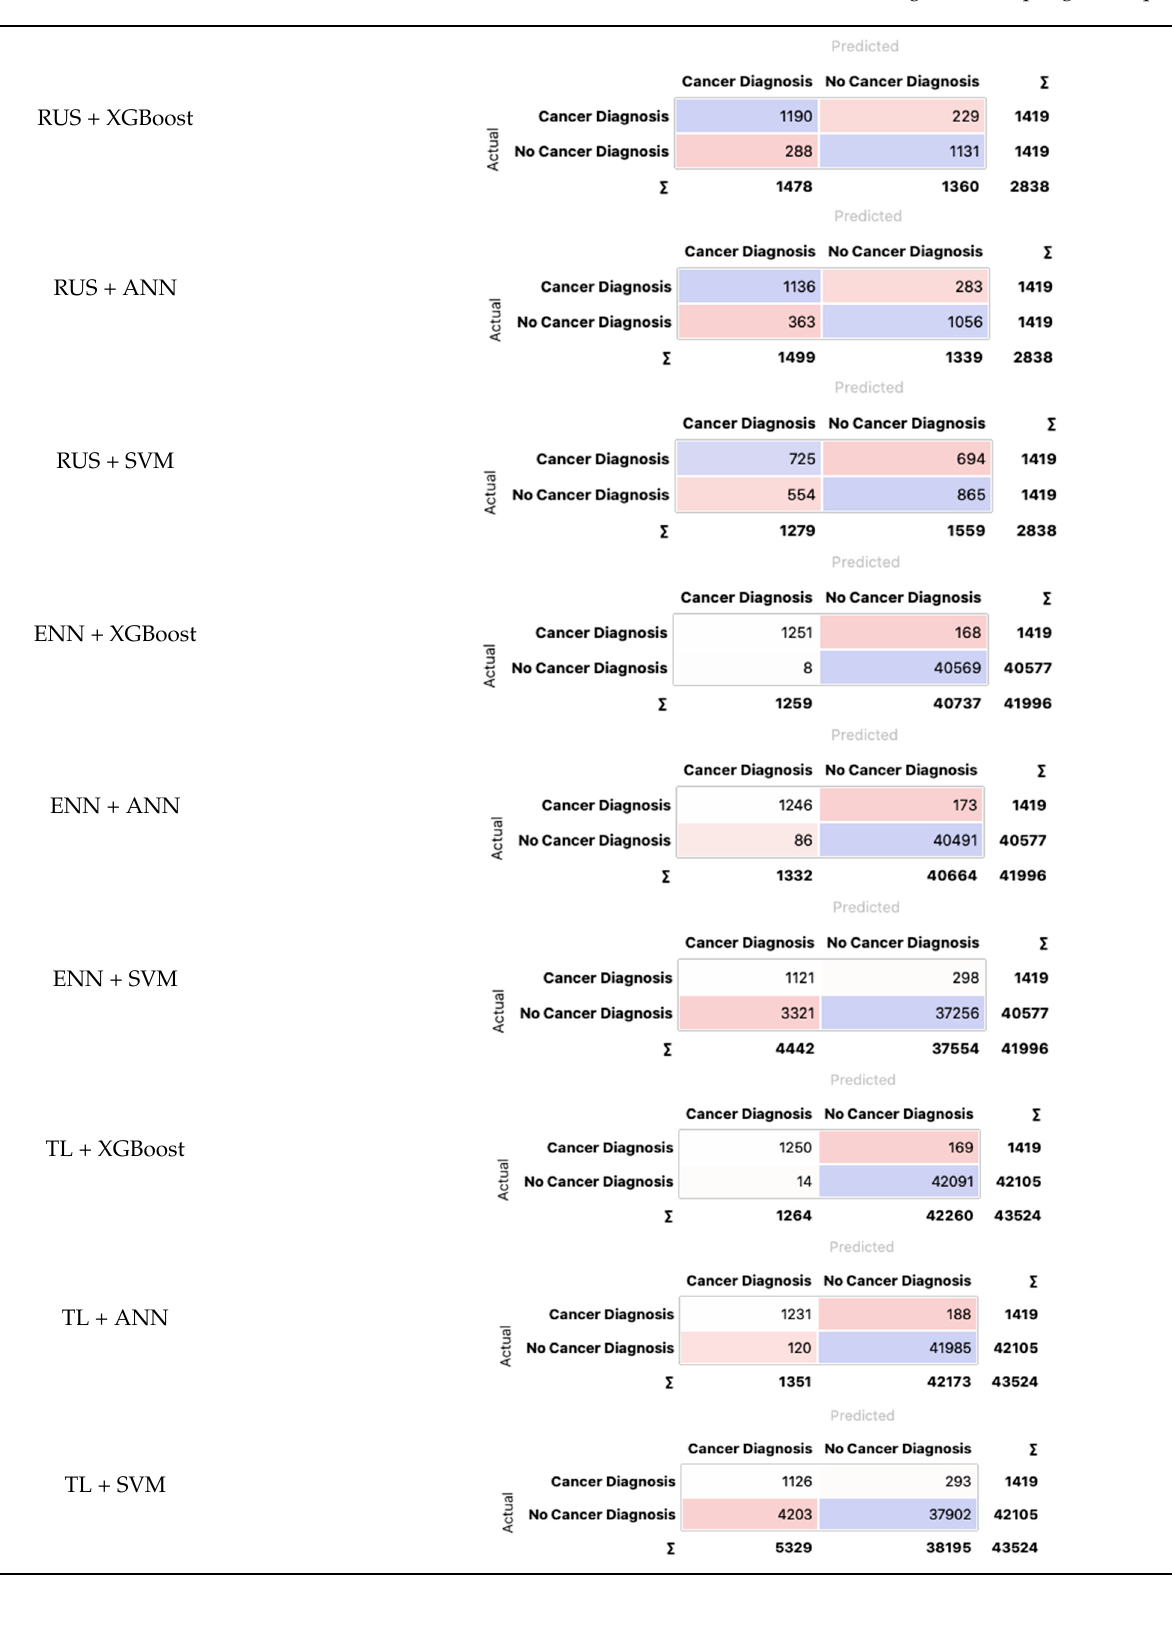
Table 10. Confusion matrix of the fusion model for datasets balanced using undersampling techniques.